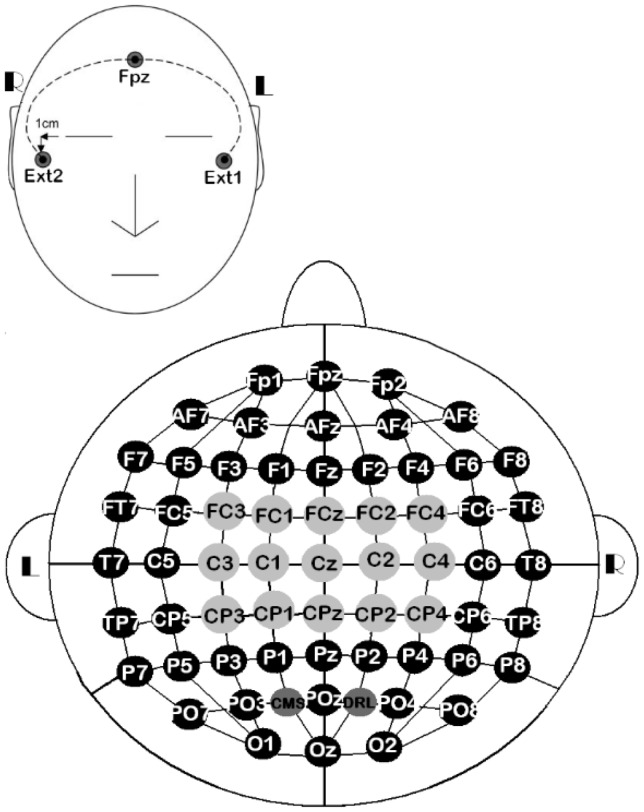
10/10 EEG layout of 61 channels, along with three external electrodes. All the EEG channels (, ) were used for the all-embracing method, 15 of them () were used for the standard method, EOGL/EOGR were used for recording eye movements, and MR was used for referencing EEG and EOG signals.